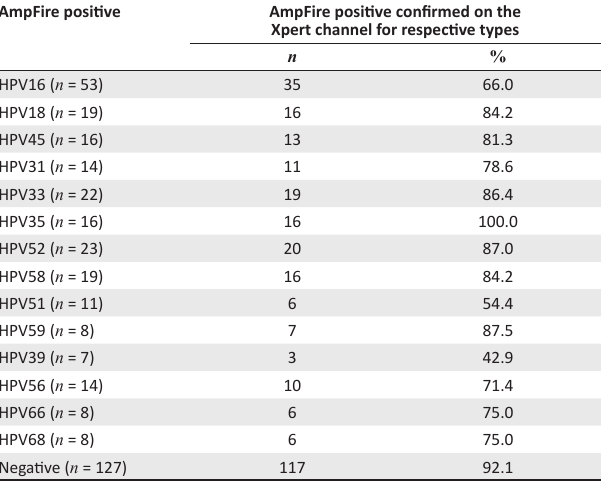
TABLE 3: Concordance of individual HPV types detected by AmpFire HPV genotyping assay with HPV groups detected by Xpert HPV assay (non- hierarchical), Rwanda, June 2018 - June 2019. AmpFire